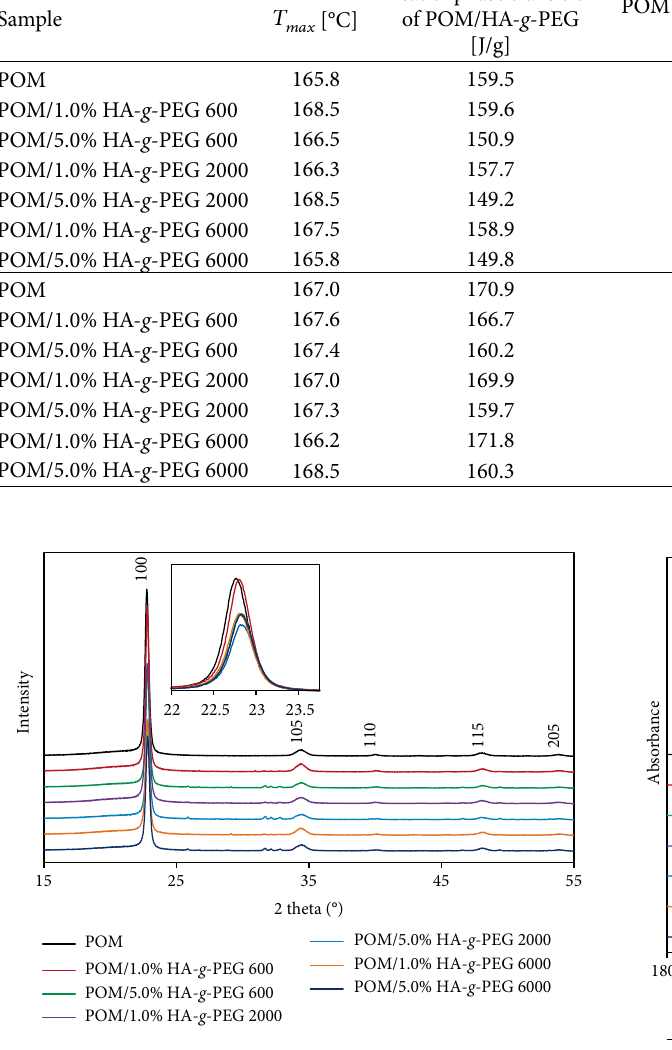
Figure 5: The XRD patterns of POM/HA- g -PEG composites in the range of 2 θ = 15–55° (a) and 2 θ = 22–24° (b).